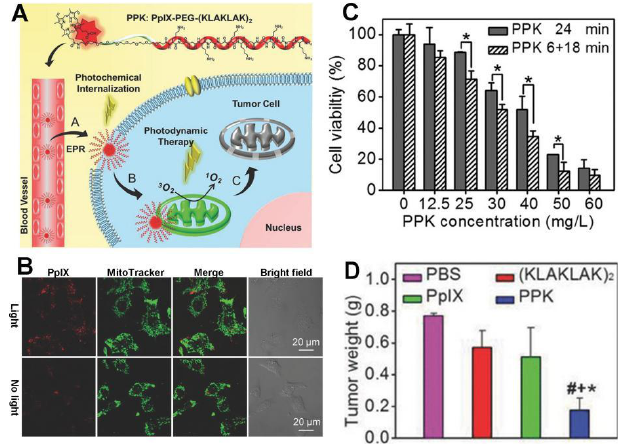
Figure 3. ( A ) Peptide-based mitochondria-targeted PT. Peptide (KLAKLAK) 2 was linked with the photosensitizer (PS) protoporphyrin (PpIX) by a short PEG linker to achieve mitochondria-oriented photodynamic therapy (PDT). ( B ) Fluorescence imaging of HeLa cells treated with PPK (PpIX–PEG–(KLAKLAK) 2 ) with and without light. ( C ) Cell viability of HeLa cells in the presence of PPK under 24 min and 6 + 18 min of light irradiation. * p < 0.01, when the group was compared with cells treated with PPK upon 24-min light irradiation as measured by a Student's t -test. ( D ) The average tumor weight at day 12 after treatment. # p < 0.05, + p < 0.05, and * p < 0.05 were determined by a Student's t -test when the group was in comparison with the groups that were treated with PBS, (KLAKLAK) 2 , and PpIX, respectively. Reprinted with permission from Ref. [94]. Copyright 2015 Wiley.